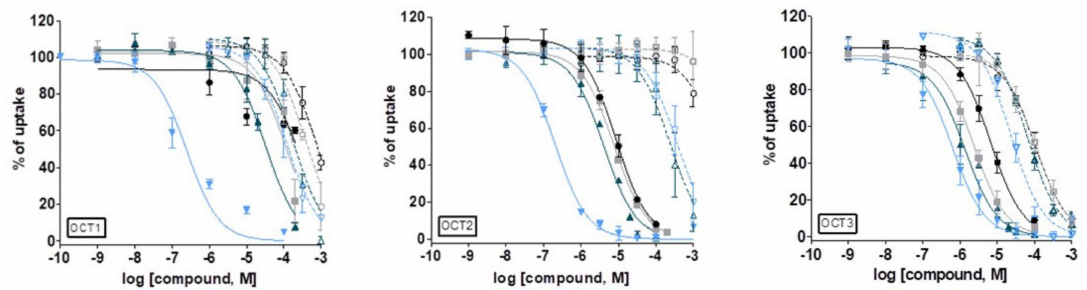
Figure 10. Concentration-response curves of [H 2 L R ]Cl and 1 – 4 for the inhibition of [ 3 H]-MPP + uptake via organic cation transporter (OCT) 1–3. HEK cells stably expressing human isoforms of OCT1–3 were incubated with the increasing concentrations of the tested drugs and tritiated substrate, [ 3 H]-MPP + , for 10 min. Curves were fitted using nonlinear regression and data points are expressed as the mean ± SD of 3–4 experiments performed in triplicates. [H 2 L H ]Cl ( ○ ), [H 2 L Me ]Cl ( □ ) , [H 2 L Et ]Cl ( ) , [H 2 L Ph ]Cl ( ), 1 (●), 2 ( ■ ), 3 ( ▲ ), 4 ( ▼ ).